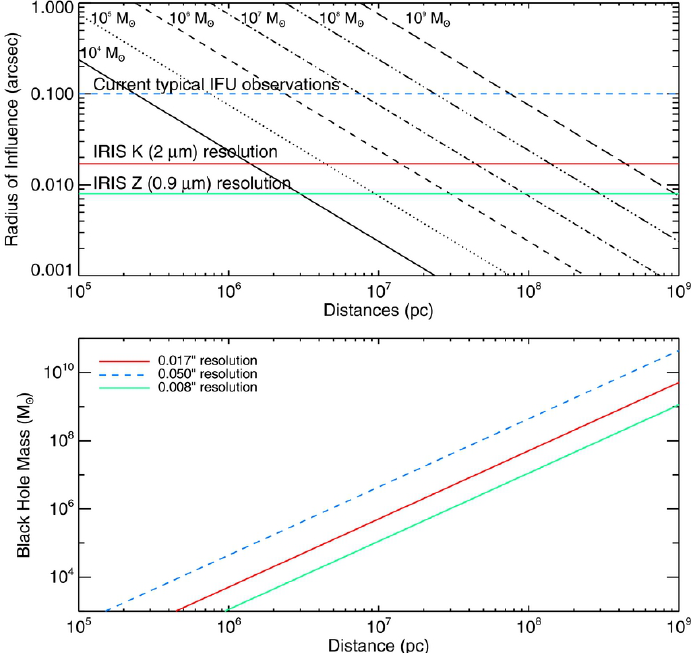
Figure 19. ( Top ) The projected radius of influence for a range of black hole masses (black lines) plotted as a function of distance. Overlaid are the angular resolution limits of current typical IFU observations (blue dashed) and those anticipated for IRIS at K (red) and Z (green) bands, respectively. The enhancement in resolving capability brought about by 30-m class telescopes will push the frontier of black hole mass measurements to further distances. ( Bottom ) Lower limits on the black hole mass measurements are shown as a function of distance. Figure from Do et al. [267]; © AAS, reproduced with